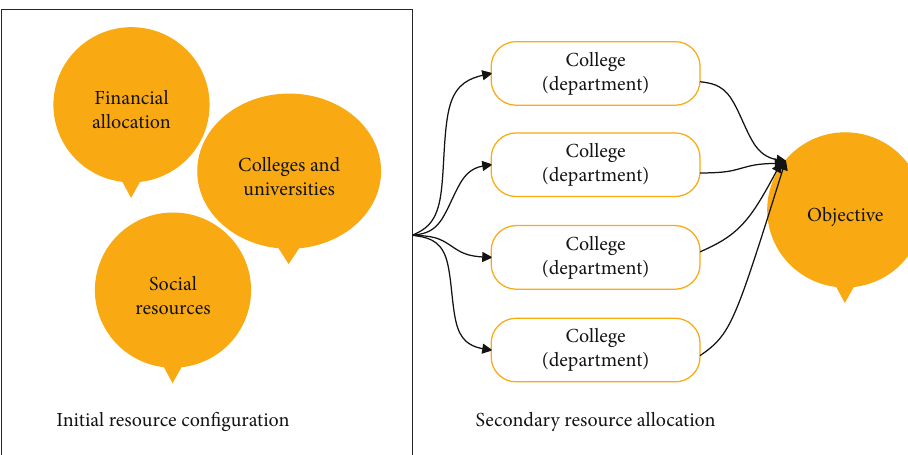
Figure 6: Budget resource allocation of colleges and universities.